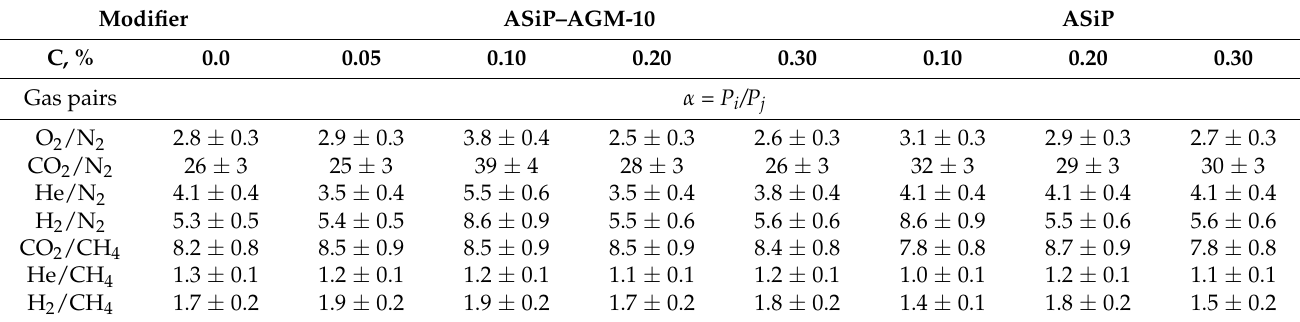
Table 2. Ideal selectivity for gas pairs ( α = P i /P j